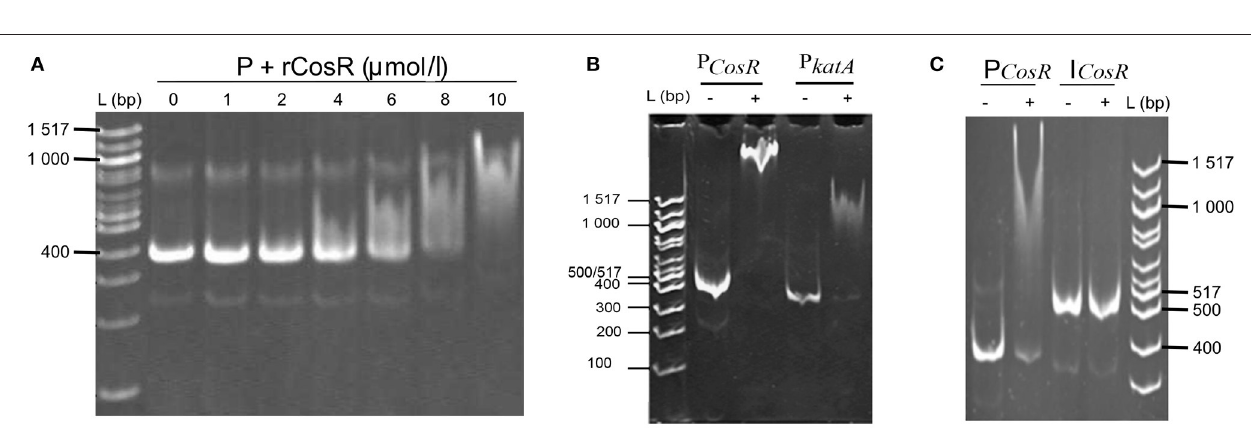
FIGURE 4 | Promoter sequence alignment. (A) Consensus sequence logo from upstream sequence of the promoter region of genes responsible for ROS scavenging ( ahpC , cosR , katA and sodB ). (B) Consensus sequence logo of CosR-binding box of the upstream sequences of genes with CosR-binding capacity ( ahpC , cmeA , cosR , dps , katA , luxS , and sodB ). Both logos are based on sequences from 9 strains listed in Supplementary Table 1 . D–A, T or G; H–A, T or C; N–A, T, C or G; W–A or T.